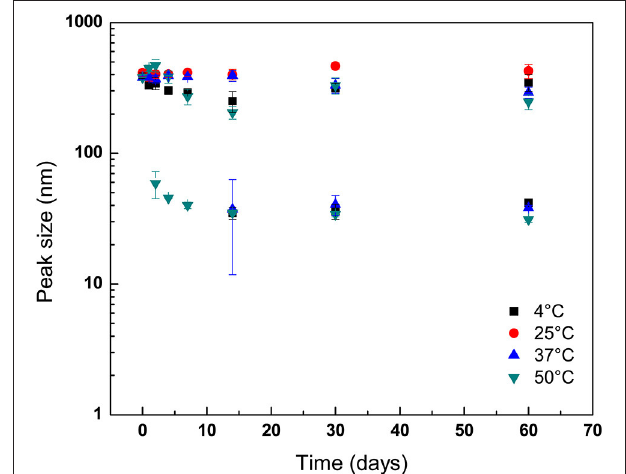
FIGURE 3 | Stability of geraniol-loaded nanoparticles over 60 days of storage in milli-Q water (pH 7.0) as a function of storage temperature. Particle size and polydispersity was determined by dynamic light scattering. Symbols depict means taken from two identical independent replications, with duplicate readings taken per sample and then averaged ( N = 2); error bars indicate one sample standard